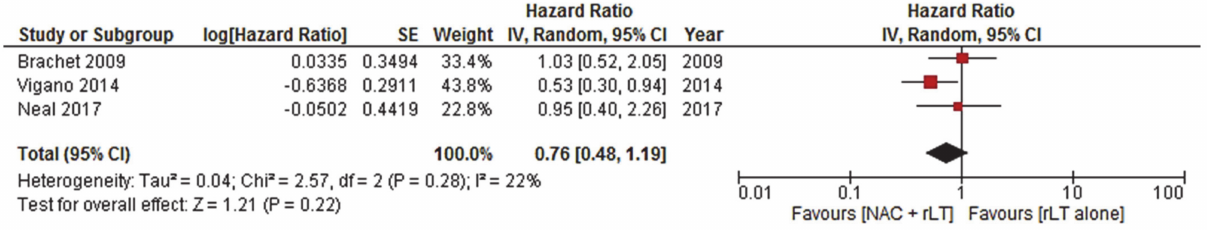
Figure 2. NAC + rLT versus rLT alone: OS.